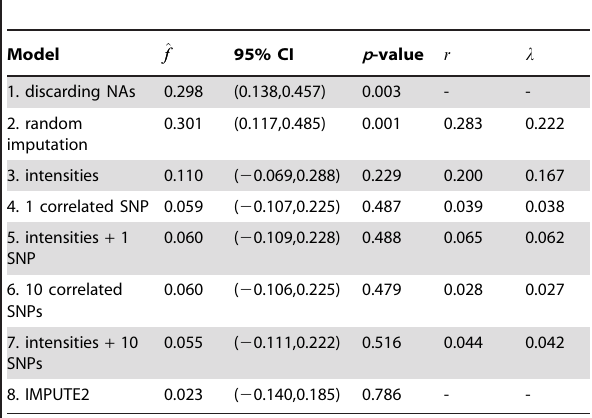
Table 2. Inbreeding coefficients, confidence intervals, p - values and missing data statistics (relative increase in variance ( r ), and fraction of missing information ( l )) for multiple imputation with different multinomial logit models, and for single imputation with